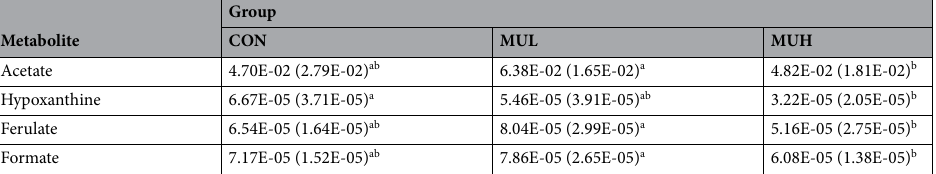
Table 4. Caecal metabolites showing significantly different concentrations (mmol/L) between CON, MUL, and MUH at slaughter (42 d) † . † Table entries are means and standard deviation in brackets. a, b Within a row, means with no common superscripts differ significantly ( p -value < 0.05).